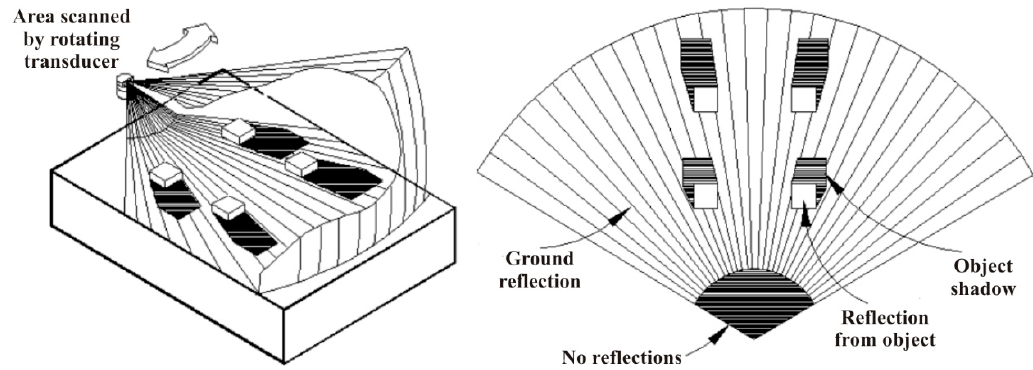
Figure 1. Diagram showing scanning procedure and idealization of expected return of used sonar [28]. Table 1. Sonar